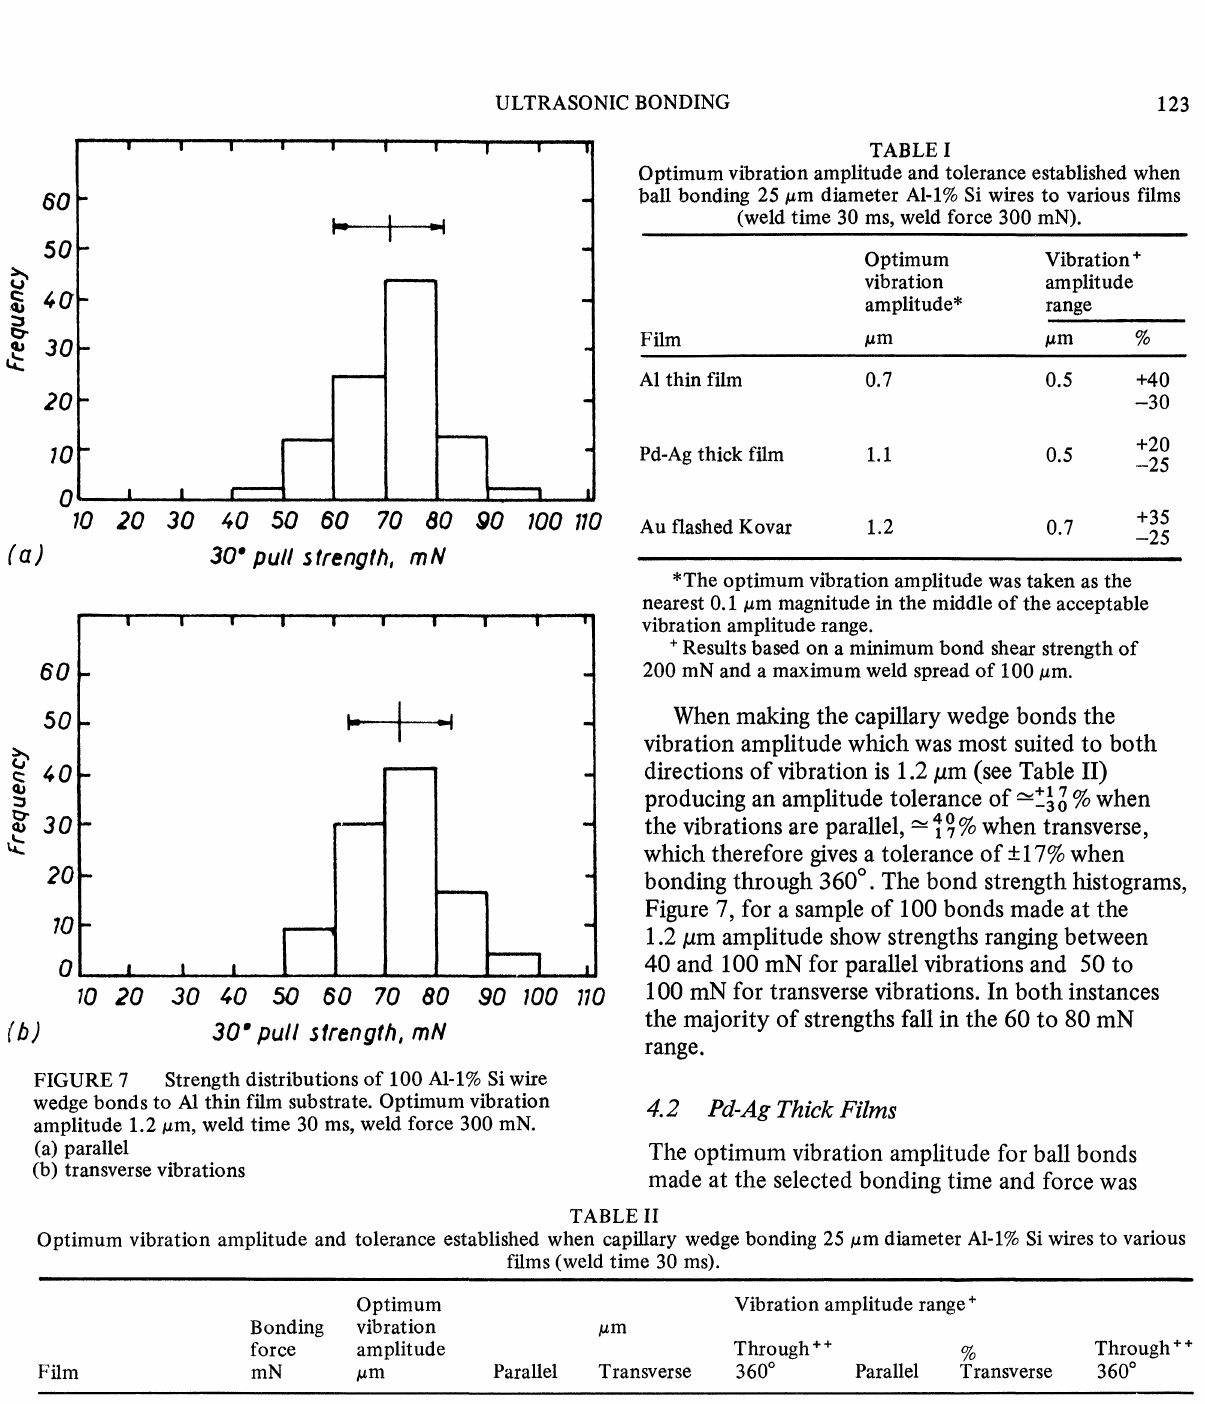
TABLE Optimum vibration amplitude and tolerance established when ball bonding 25/m diameter Al-l% Si wires to various films (weld time 30 ms, weld force 300 mN).